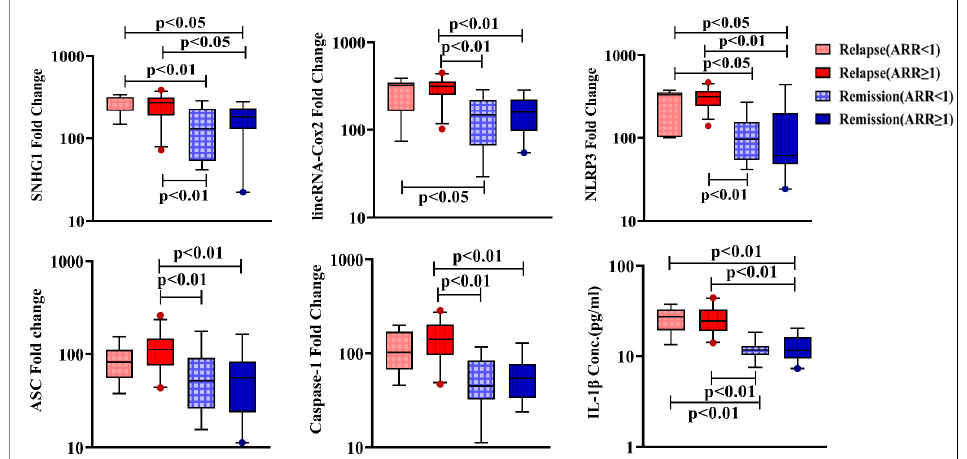
Figure 3. Expression levels of SNHG1, lincRNA-Cox2, NLRP3, ASC, and caspase-1 and serum IL-1 β levels in RRMS patients during relapse and in remission with ARR < 1 (n = 7 and 16, respectively) and ARR ≥ 1 (n = 28 and 19, respectively. Box plots show the median as a band inside each box, while boxes and whiskers delineate 25–75th and 10–90th percentiles, respectively. Dots outside the whiskers indicate outliers. Signi fi cant p -values are indicated on the graph at p < 0.05.